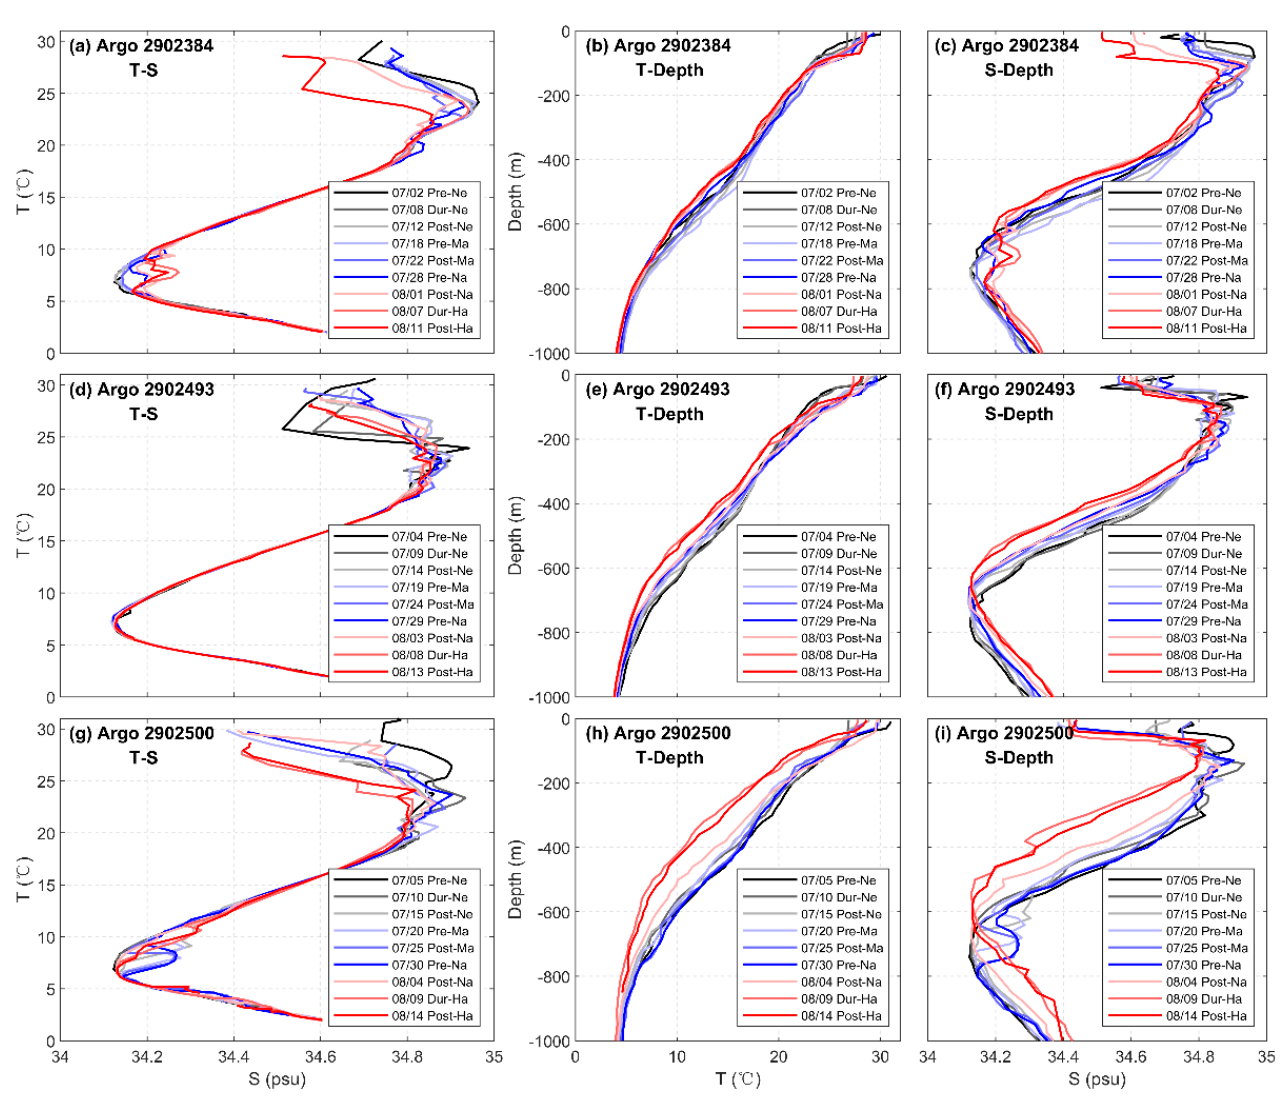
Figure 8. Temperature and salinity profiles measured by Argos 2902384 (a-c), 2902493 (d-f) and 2902500 (g-i). TC Neoguri, Matmo, Nakri, and Halong were abbreviated to Ne, Ma, Na, Ha. Pre, Dur and Post indicated Pre-TC, During TC and Post-TC, respectively.